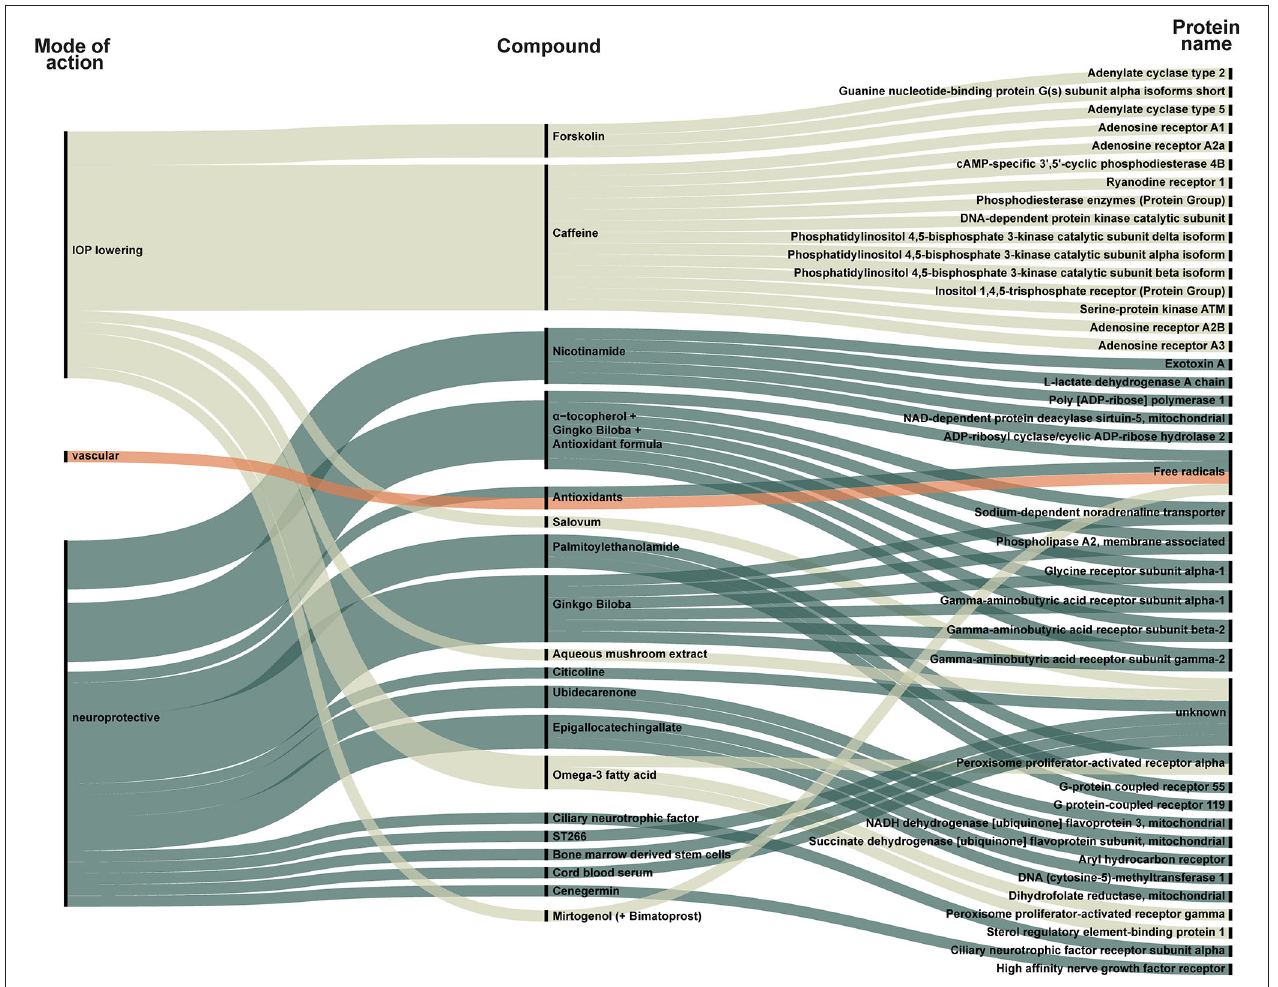
FIGURE 3 | New compounds classified as supplements, stimulants, or transplant identified in all included trials. Each compound is categorized as IOP-lowering (light green), vascular (orange), or neuroprotective (dark green). The compound is linked to its target. The targets are listed to the right and visualize how some compounds act on several targets. For example, forskolin is an IOP-lowering compound that targets adenylate cyclase type 2, G(s) subunit alpha-isoforms short, and adenylate cyclase type 5. Only one group of vascular compounds, namely antioxidants, that act on free radicals, is represented.